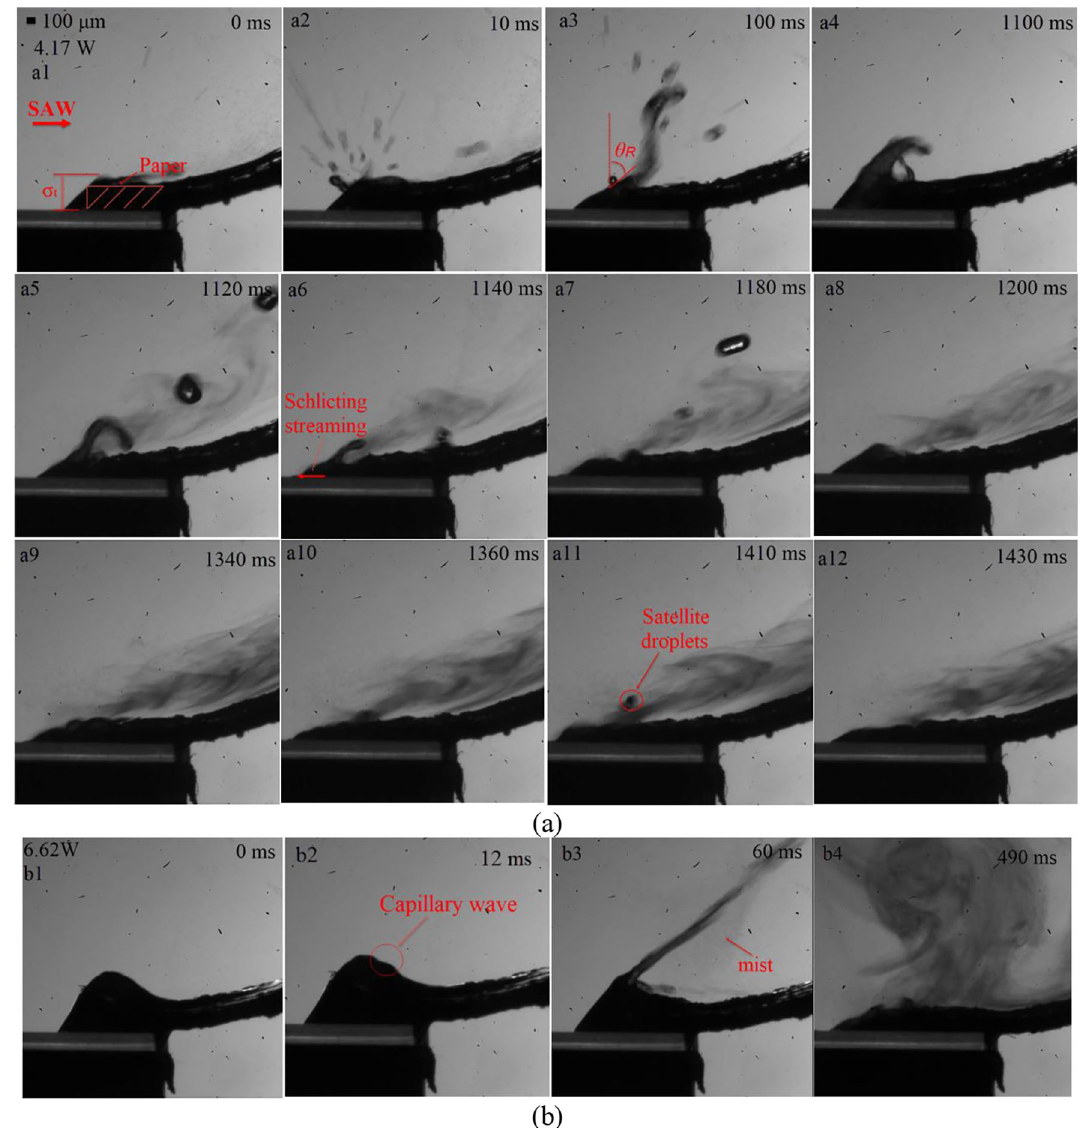
Figure 5. Continuous atomization process of liquid supplied by paper over time. The cross-hatched box indicates the position of the paper strip. ( a ) Atomization behavior with a SAW frequency of 30 MHz at a power of 4.17 W. ( b ) Atomization behavior with a SAW frequency of 30 MHz at a power of 6.62